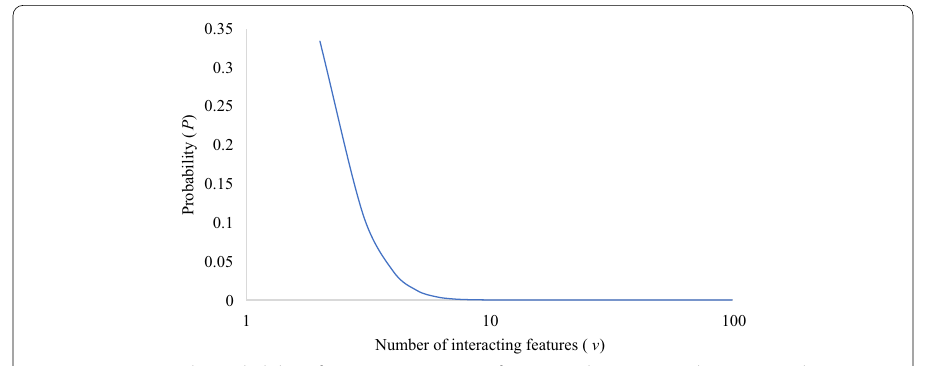
Fig. 2 Given s 3, the probability of grouping interacting features is decreasing with respect to the = increasing number of interacting features v